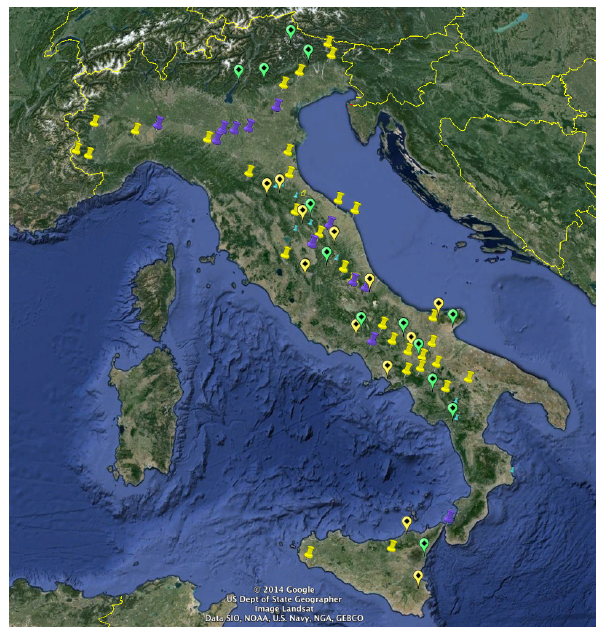
Figure 2. Location of the accelerometric stations considered for empirical testing. Dotted pins refer to stations on soil type A or A ∗ (* for hypothesized conditions) in Eurocode 8 (EN-1998, 2004) classification, pin colours represent simplified amplification factors for PGA (NTC, 2008) used to accomplish stratigraphic and topo- graphic site response: green = 1, yellow = 1.2–1.35, violet ≥